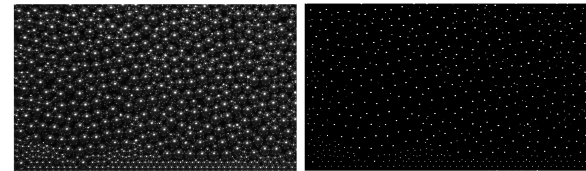
Figure 2. Typical captured image:The particles are seen as bright spots (left). Detected particle as a white cluster after thresholding (right).